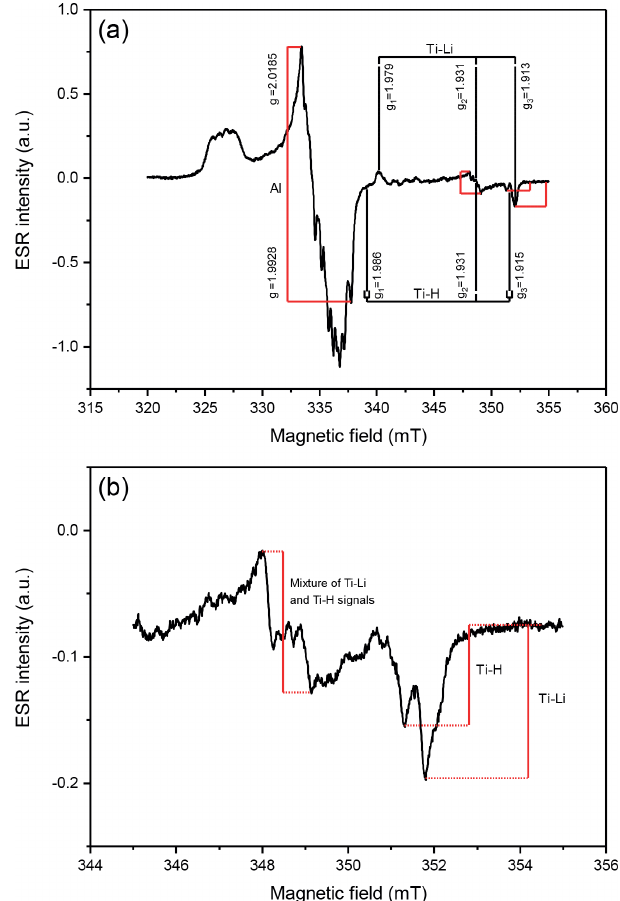
Figure 1. (a) The natural Al centre and Ti centres of sample RB-II and overview of the g values; (b) close-up of titanium signals of sample RB-II after annealing and giving 500Gy of artificial irradi- ation.